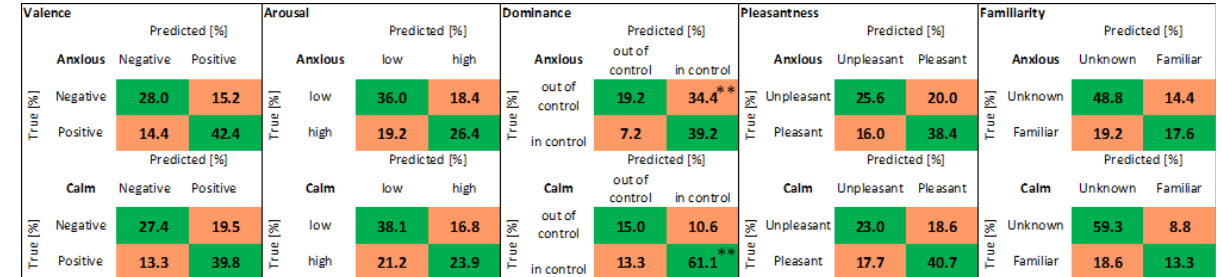
Figure 15. Confusion matrices. Values distributed into the two classes: Anxious, Calm. Classification obtained with: KNN algorithm, PRV + SP features, LOSO cross-validation. The values marked with two asterisks, in the box relating to the dominance variable, are significantly different (Mann–Whitney test, two-tailed, based on the values that refer to each volunteer). p = 0.0064.